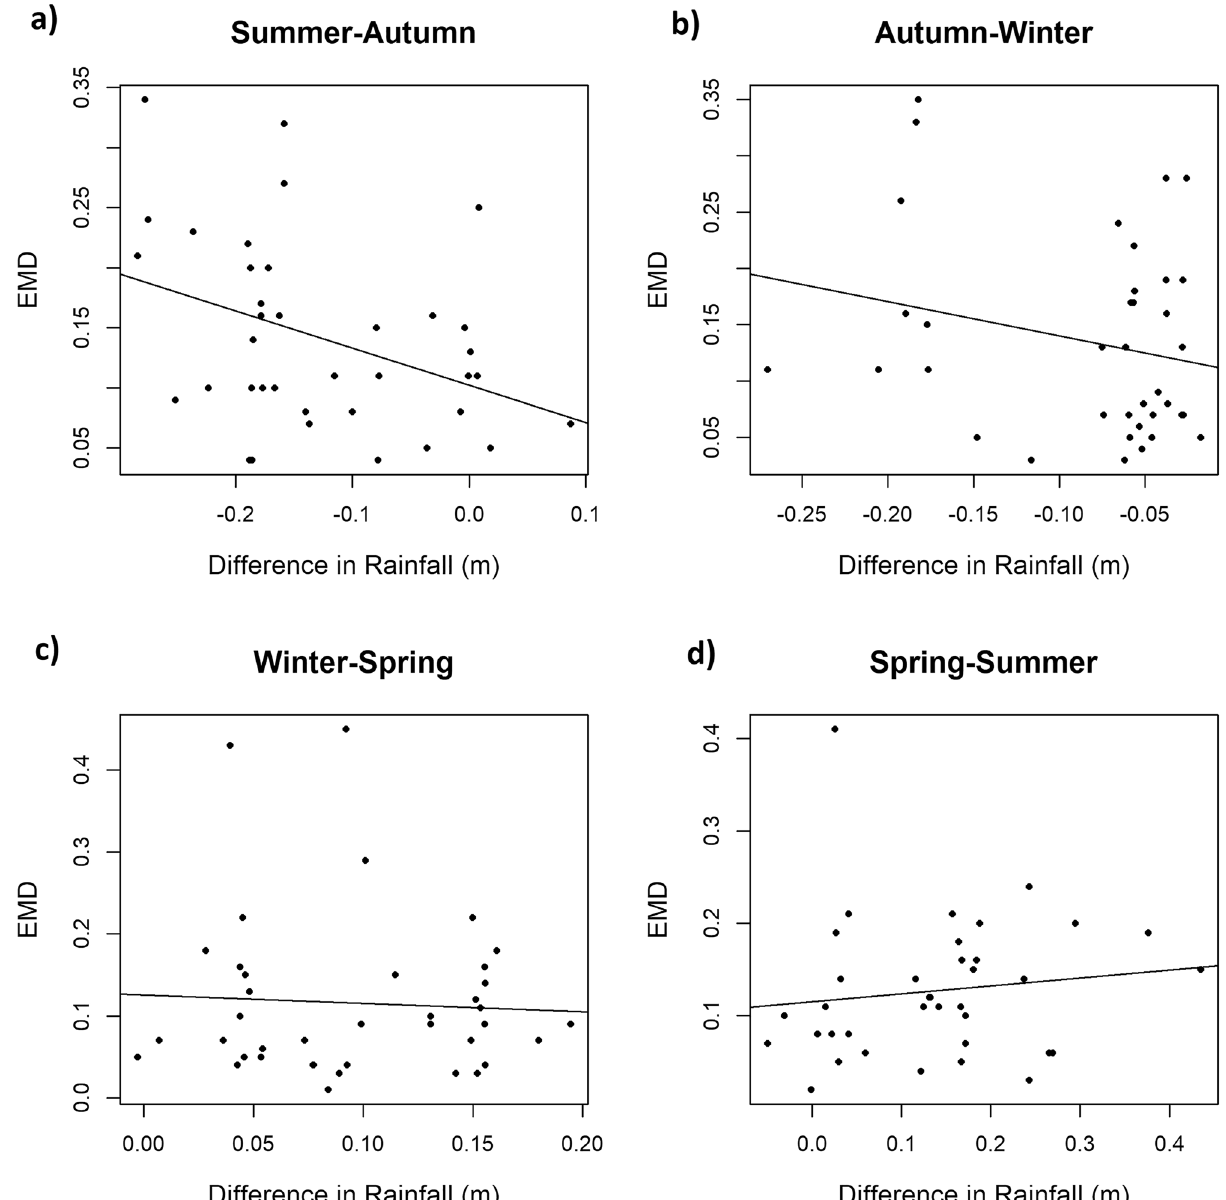
Figure 4. The relationship between difference in rainfall for consecutive seasons within the same year and Earth Mover’s Distance (EMD) for ( a ) summer and autumn ( b ) autumn and winter ( c ) winter and spring and ( d ) spring and summer comparisons. Negative values in rainfall difference indicates lower rainfall in the second season compared to the first, and vice versa. Lower values in EMD indicate higher